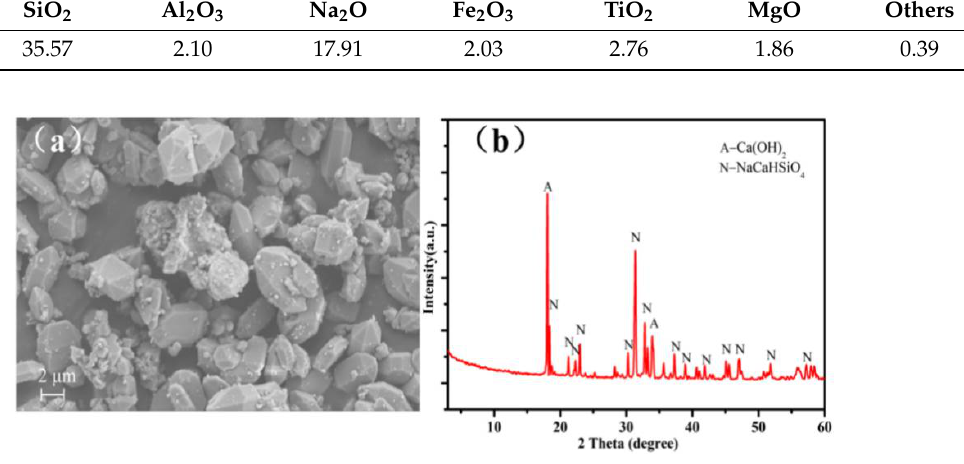
Table 2. Ranges and values of the experimental parameters for 11Å-TA synthesis using AER.